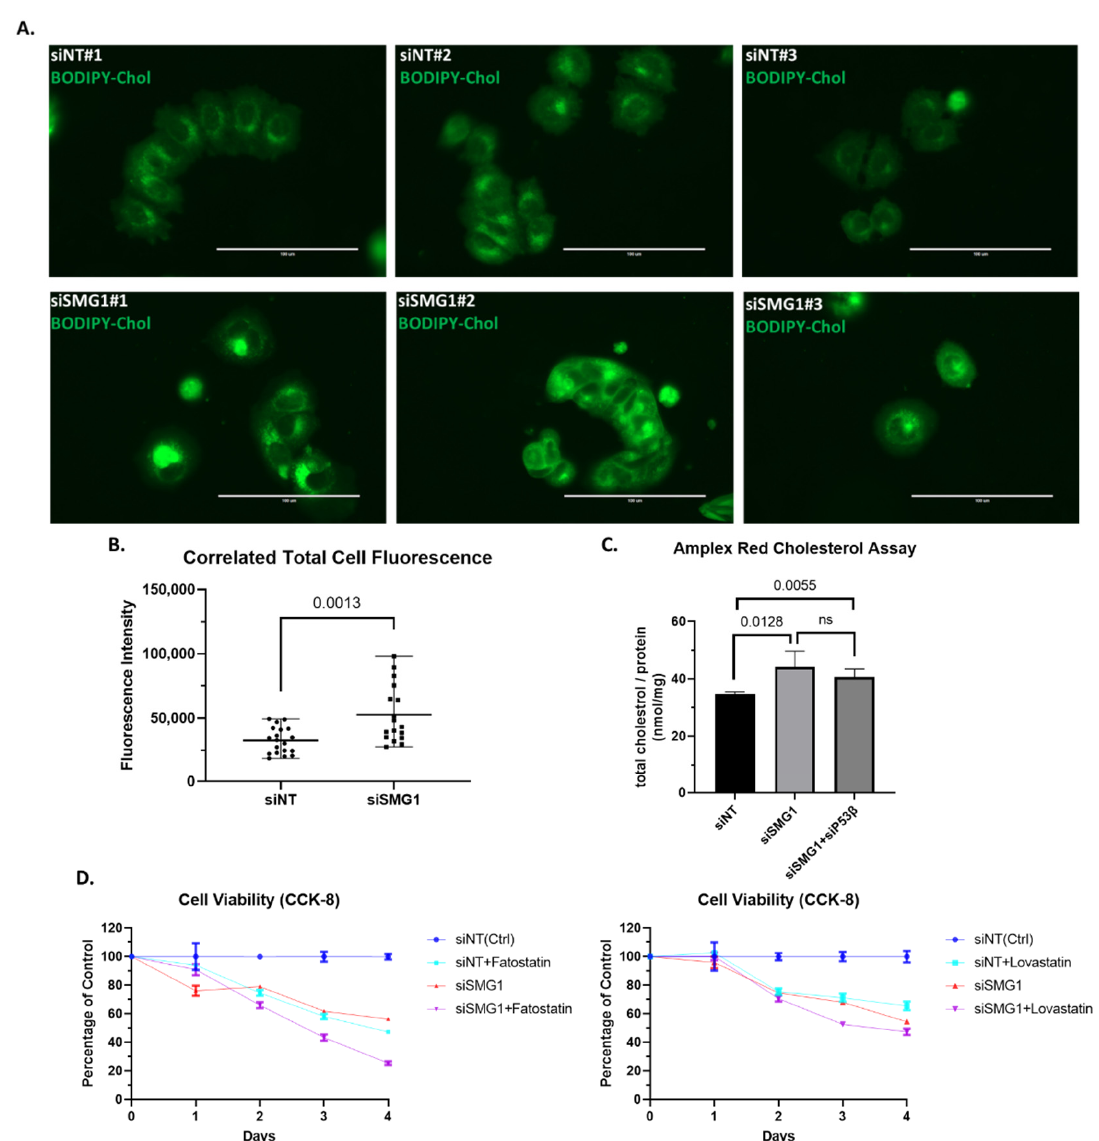
Figure 5. SMG1 knockdown increases intracellular cholesterol levels and sensitizes MCF7 cells to Fatostatin, and less degree to Lovastatin. ( A ) Representative images of the immunofluorescence